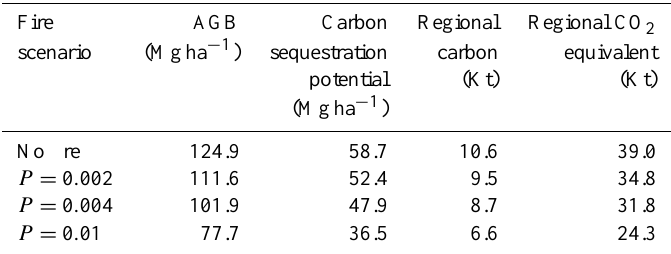
Table 3. Average above-ground biomass (AGB) and carbon sequestration potential over a 100-year period for the four forest fire scenarios (no fire and at annual fire probability of occurrence of p = 0 . 002, 0.004 and 0.01), scaled up to the regional level (181000ha of mixed forest in Castilla la Mancha) for carbon and carbon-dioxide